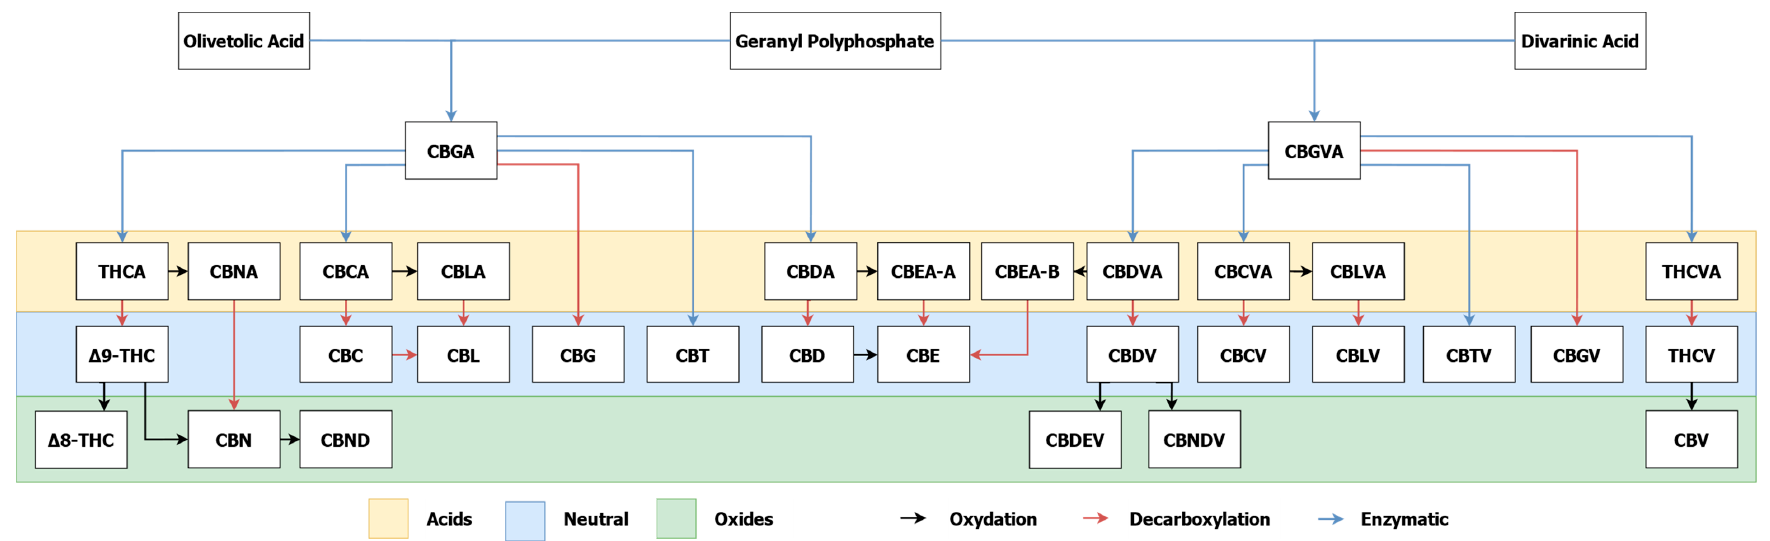
Figure 3. The Biosynthesis of most known cannabinoids [64–66], CBGA: cannabigerolic acid; CBGVA: cannabigerovarinic acid; THCA: tetrahydrocannabinolic acid; ∆ 9-THC: delta-9 tetrahydrocannabinol; Δ 8-THC: delta-8 tetrahydrocannabinol; CBNA: cannabinolic acid; CBN: cannabinol; CBND: cannabinodiol; CBCA: cannabichromenic acid; CBC: cannabichromene; CBLA: cannabicyclolic acid; CBL: cannabicyclol; CBG: cannabigerol; CBT: cannabitriol; CBDA: cannabidiolic acid; CBD: cannabidiol; CBEA-A: cannabielsoin acid A; CBEA-B: cannbielsoin acid B; CBE: cannabielsoin; CBDVA: cannabidivarinic acid; CBDV: cannabidivarin; CBDEV: cannabidielsoinvarin; CBNDV: cannabivarinodiol; CBCVA: cannabichromevarinic acid; CBCV: cannabichromevarin; CBLVA: cannabicyclolvarinic acid; CBLV: cannabicyclolvarin; CBTV: cannabitiolvarin; CBGV: cannabigerovarin; THCVA: tetrahydrocannabivarinic acid; THCV: tetrahydrocannabivarin; CBV: cannabivarin.